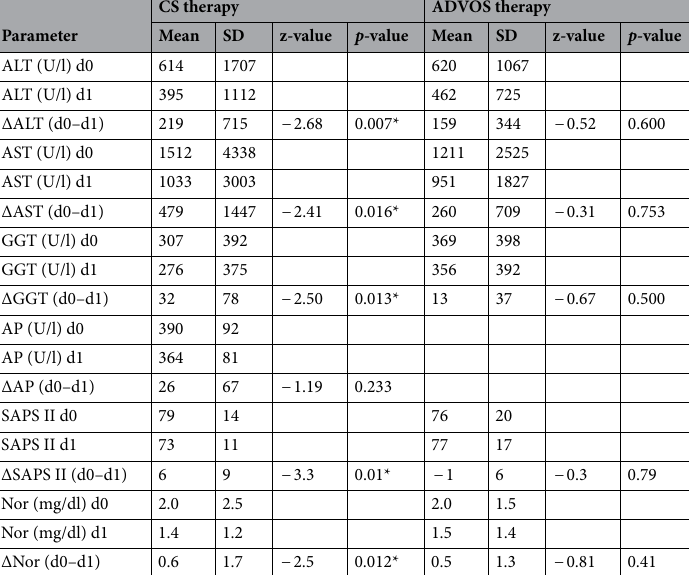
Table 2. Changes in different parameters during blood purification. CS: CytoSorb, ADVOS: advanced organ support, CI: confidence interval, SD: standard deviation, ALT: serum alanine aminotransferase, AST: serum aspartate aminotransferase, GGT: glutamine-glutamyl transferase, AP: alkaline phosphatase, SAPS: Simplified Acute Physiology Score, Nor: norepinephrine demand, d: